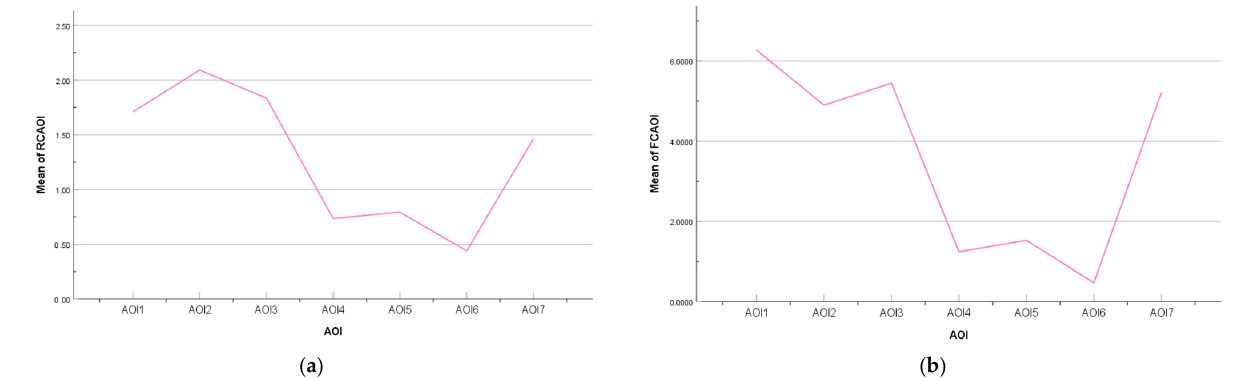
Figure 13. The partial distribution of attention among all the AOIs: ( a ) average regression count among AOIs; ( b ) average fixation count among AOIs. Table 10. Results of the multivariate-ANOVA-main-effects test for each AOI eye-movement indicator.